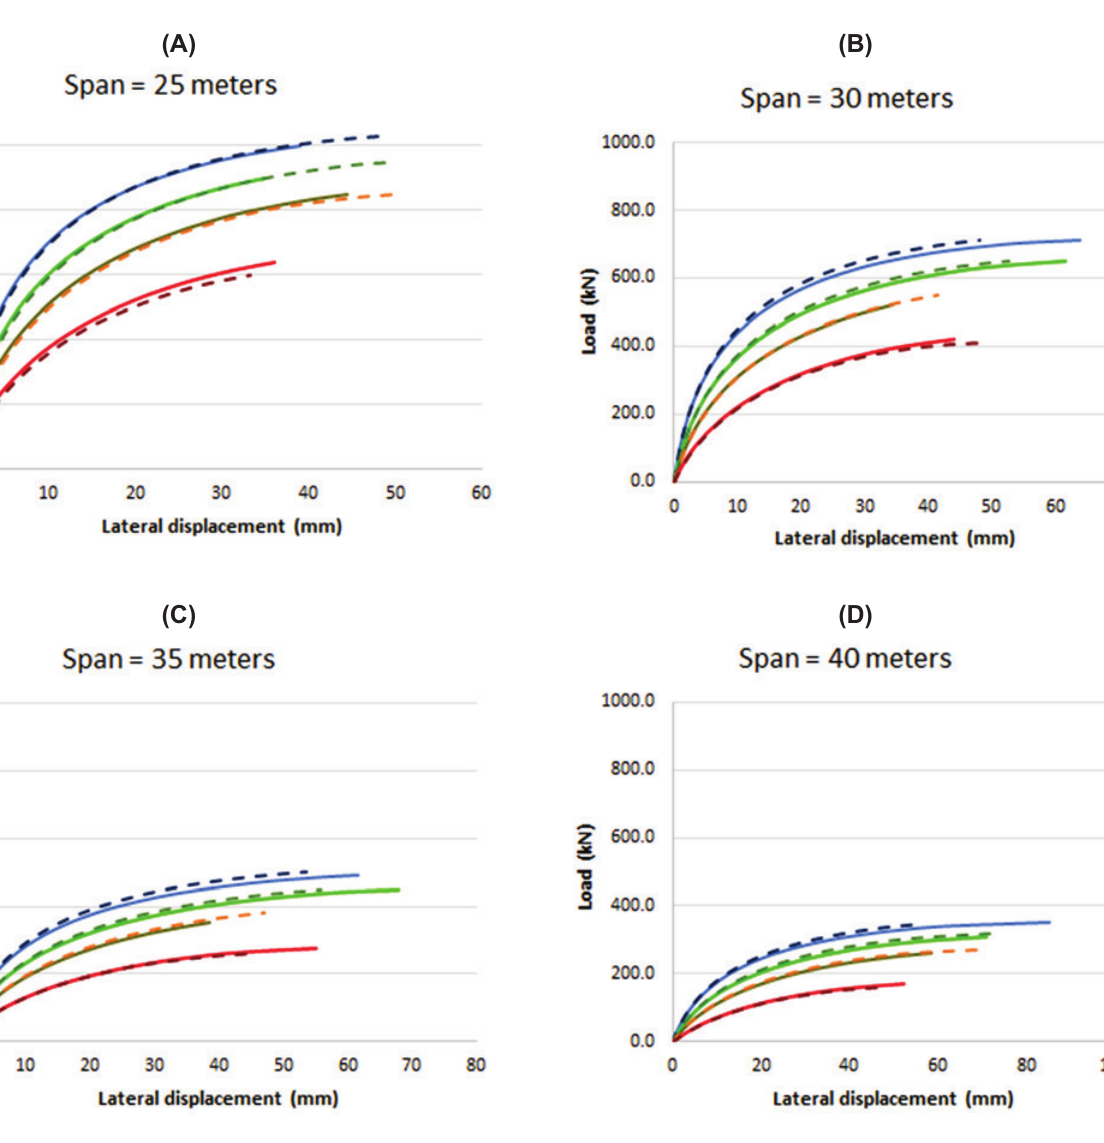
Figure 15 Load × Lateral mid-span displacement graph